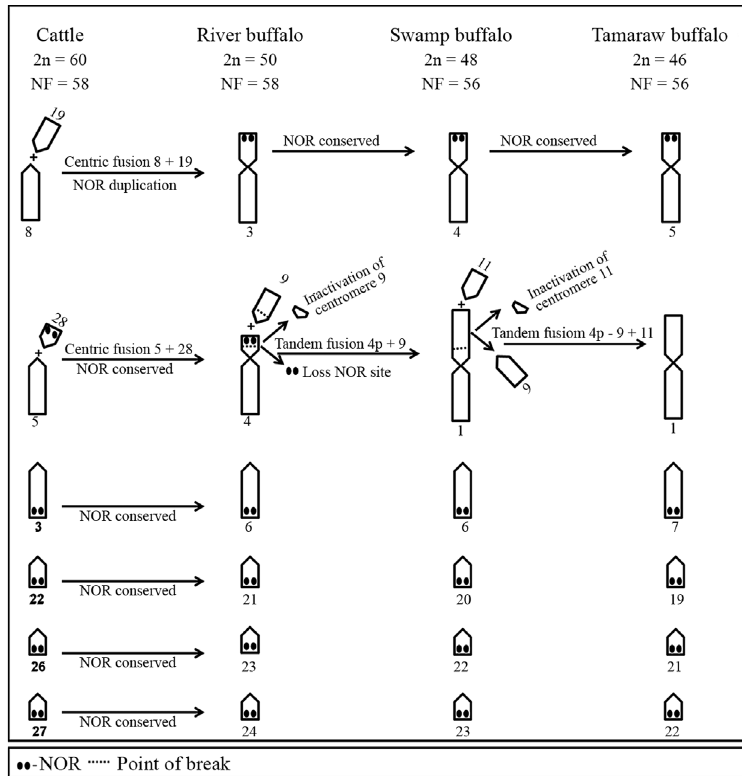
Figure3 -SchematicrepresentationoftheevolutionoftheNOR-bearingchromosomesinfourspeciesoftheBovinitribe.Thisfigurewasconstructedus- ing the standard GTG-banding ideogram according to Bongso and Hilmi (1982), Iannuzzi et al. (1990) and Tanaka et al.